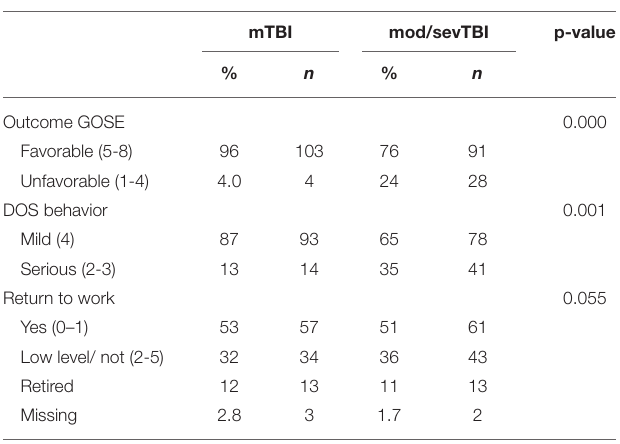
TABLE 2 | Outcome scores.